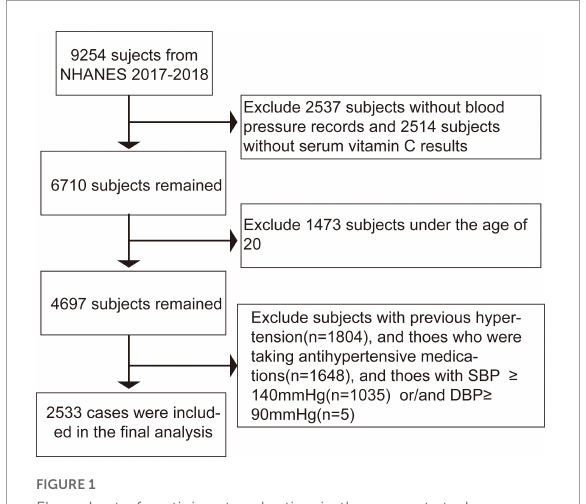
FIGURE1 Flow chart of participants selection in the present